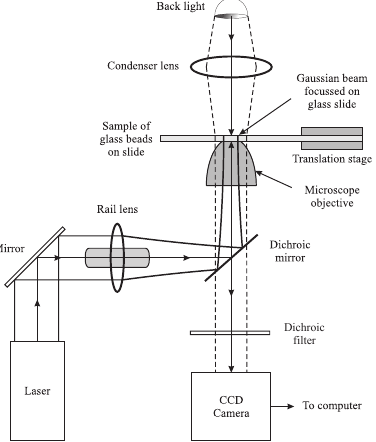
Figure 17. Schematic diagram of the optical tweezers experiment. The laser source is a diode laser operating at λ = 532 nm. The dichroic mirror ensures that most of the laser light reaches the microscope objective. The rail lens is used to vary the size of the laser beam. The objective focuses the laser beam to a spot size of ∼ 3 µ m. The sample of polystyrene glass beads in saline solution is placed at the focal spot of the laser. The sample is uniformly illuminated by a backlight. Light from this lamp source passes through a condenser lens and the sample. After passing through the microscope objective, it is imaged on a CCD camera. With the laser blocked, the CCD camera can image the glass beads suspended in solution. When the optical dipole force trap is aligned, the dichroic mirror and dichroic filter ensure that a small fraction of the light scattered by the trapped beads reaches the CCD camera. The scattered light follows the same optical beam path as the backlight and is sufficiently intense for the trapped bead to be